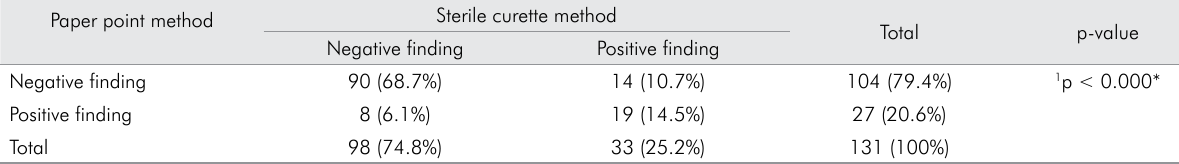
Table 3. Comparison of sampling methods for subgingival plaque